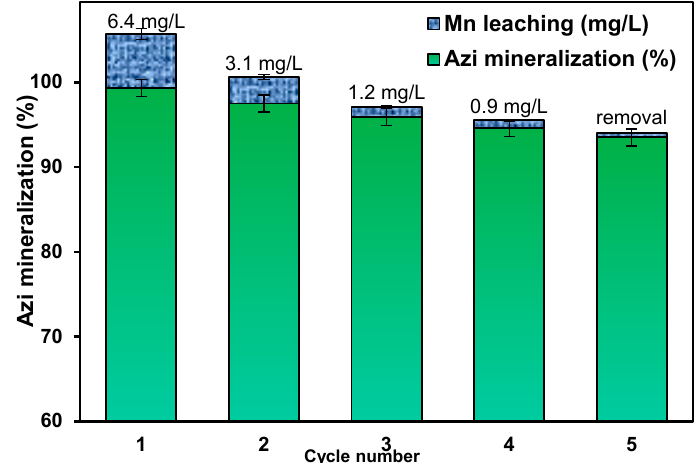
Figure 11. The stability of the catalyst in consecutive regenerating cycles; pH = 5, Mn-BTC arg /Al catalyst dosage of 6 g/L, Azi concentration of 0.02 g/L and H 2 O 2 concentration of 1 g/L.